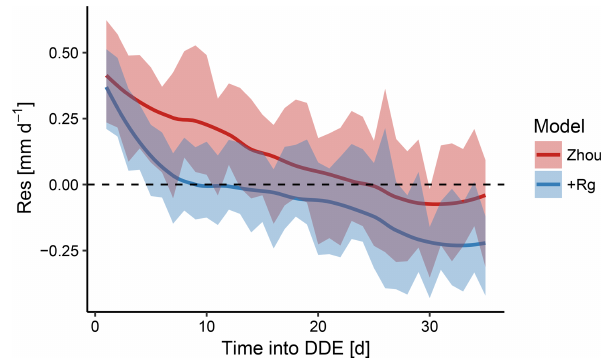
Figure 4. Mean model residuals across all dry-down events for the Zhou and + Rg model as a function of time during dry-down events. The shaded area reflects the 95% confidence intervals. Both mod- els tended to underestimate ET near the beginning of the dry-down event while overestimating the flux with increasing length of the event. The former was more pronounced for the Zhou model and the latter more pronounced for the + Rg model.